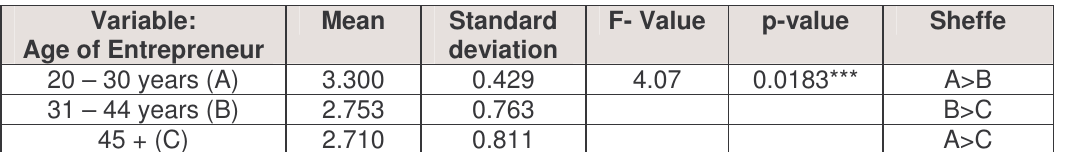
Table 8: ANOVA between different age groups of entrepreneurs regarding support (partners and advisors)